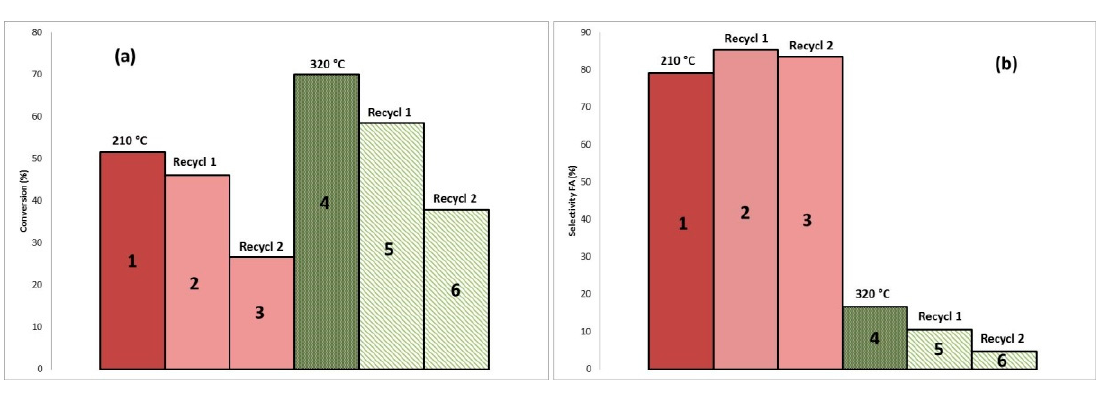
Figure 4. ( a ) Conversion; and ( b ) selectivity to FA at 210 °C (columns 1–3) and at 320 °C (columns 4–6).